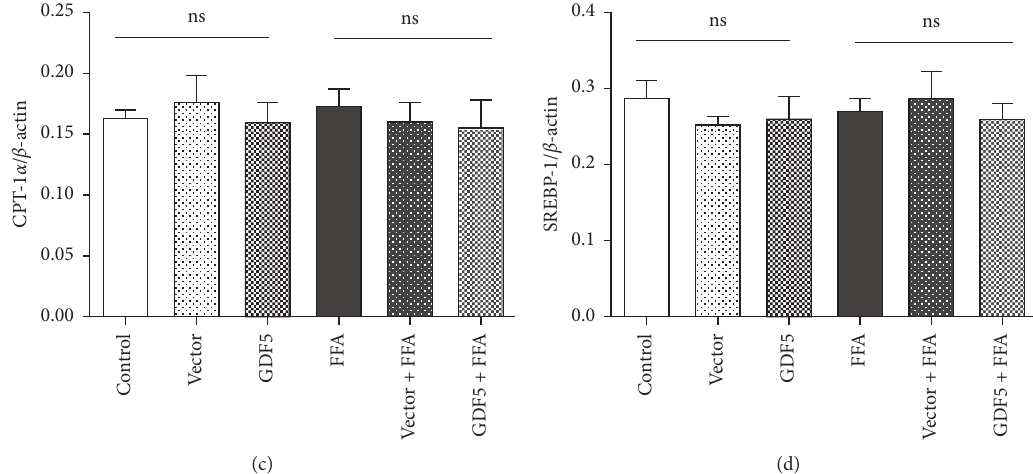
Figure 6: Immunoblot analysis (a) and quantification of NAFLD-related genes in different LO2 cells after FFA induction. Relative ex- pression of PPAR α , CPT-1 α , and SREBP-1; (b) CPT-1 α : carnitine palmitoyltransferase-1 α ; (c) SREBP-1: sterol regulatory element-binding protein 1; and (d) PPAR α : peroxisome proliferator-activated receptor α . ( ∗ : P < 0 . 05; ∗∗ : P < 0 .